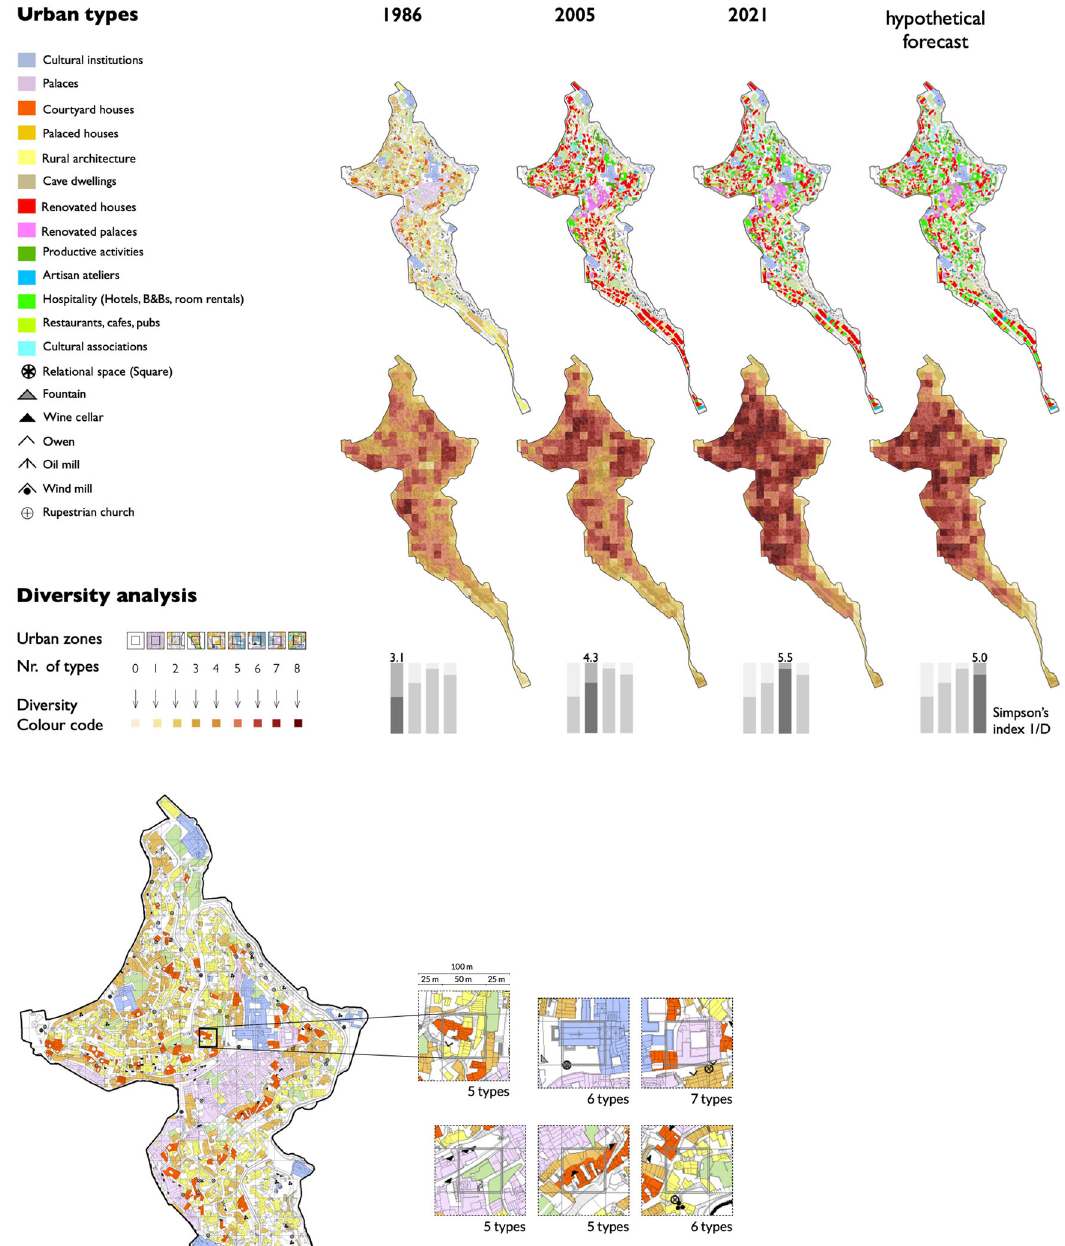
Fig. 6 Cycles of diversi fi cation in urban space. Life is diverse. Yet, diversity is not stable; it comes and goes. As shown earlier (Fig. 4), entire cycles of diversi fi cation can be observed in science and scienti fi c fi elds. The cycles can also be observed in urban environments, for example in Sassi di Matera, a UNESCO world heritage site in Italy. The four maps above show how buildings have been used over the course of the last several decades. The four maps below are diversity maps created with the method shown in the lower left. Simpson index is displayed below each diversity map. Note how the diversity index goes up and down. The cycles are very common. They are traditionally termed “ gentri fi cation cycles ” . Source: Baciu and Della Pietra (2021). License: